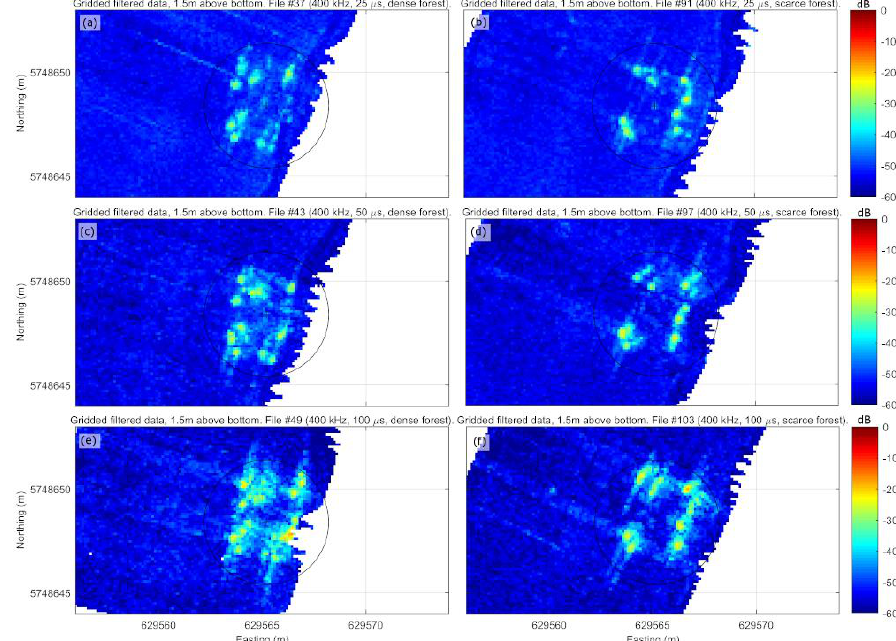
Figure 10. Horizontal slice-through at 1.5 m above the seafloor for a file acquired at 400 kHz over the dense or thin forest patch, using different pulse length settings: ( a ) 25 μs pulse data on dense forest, dense or thin forest patch, using di ff erent pulse length settings: ( a ) 25 µ s pulse data on dense forest, ( b ) 25 μs pulse data on thin forest, ( c ) 50 μs pulse data on dense forest, ( d ) 50 μs pulse data on thin ( b ) 25 µ s pulse data on thin forest, ( c ) 50 µ s pulse data on dense forest, ( d ) 50 µ s pulse data on thin forest, ( e ) 100 μs pulse dat a on dense forest, ( f ) 100 μs pulse data on thin forest. The cross is the centre forest, ( e ) 100 µ s pulse data on dense forest, ( f ) 100 µ s pulse data on thin forest. The cross is the centre of the patch. The 3 m radius circle is the base of the target volume. of the patch. The 3 m radius circle is the base of the target